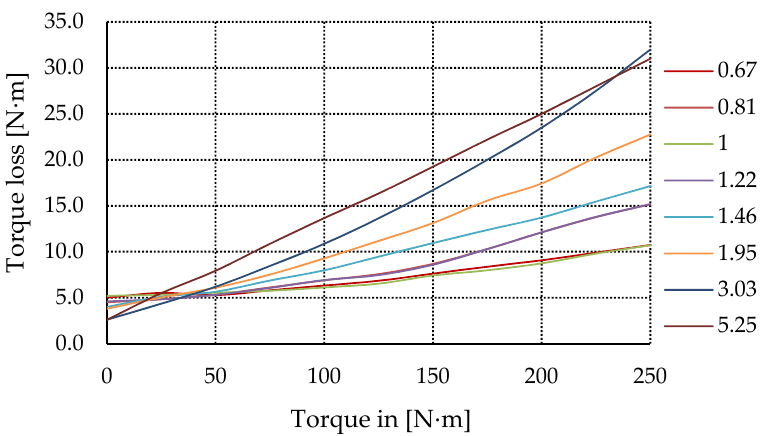
Figure 6. Waveform of transmission torque loss variations as a function of the input shaft torque and gear ratio value [75].